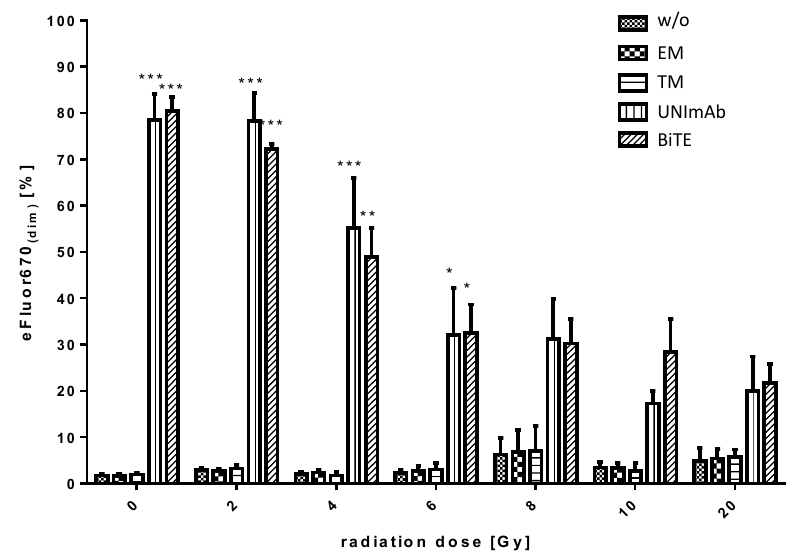
Figure 7. Proliferation of irradiated T cells. Irradiated and unirradiated pan T cells were redirected to PC3-PSCA cells in the absence (w/o) or presence of 30 pmol/mL of the respective Ab components (effector module alone (EM), target module alone (TM), UNImAb complex (UNImAb), conventional BiTE (BiTE)) for 5 d. Before irradiation, the T cells were stained with the proliferation dye eFluor ® 670. Proliferation was measured by FACS analysis. Summarized data of three individual donors are shown. (* p < 0.05; ** p < 0.01 and *** p < 0.001 in relation to controls w/o Ab; one-way ANOVA, Bonferroni Multiple Comparison test).